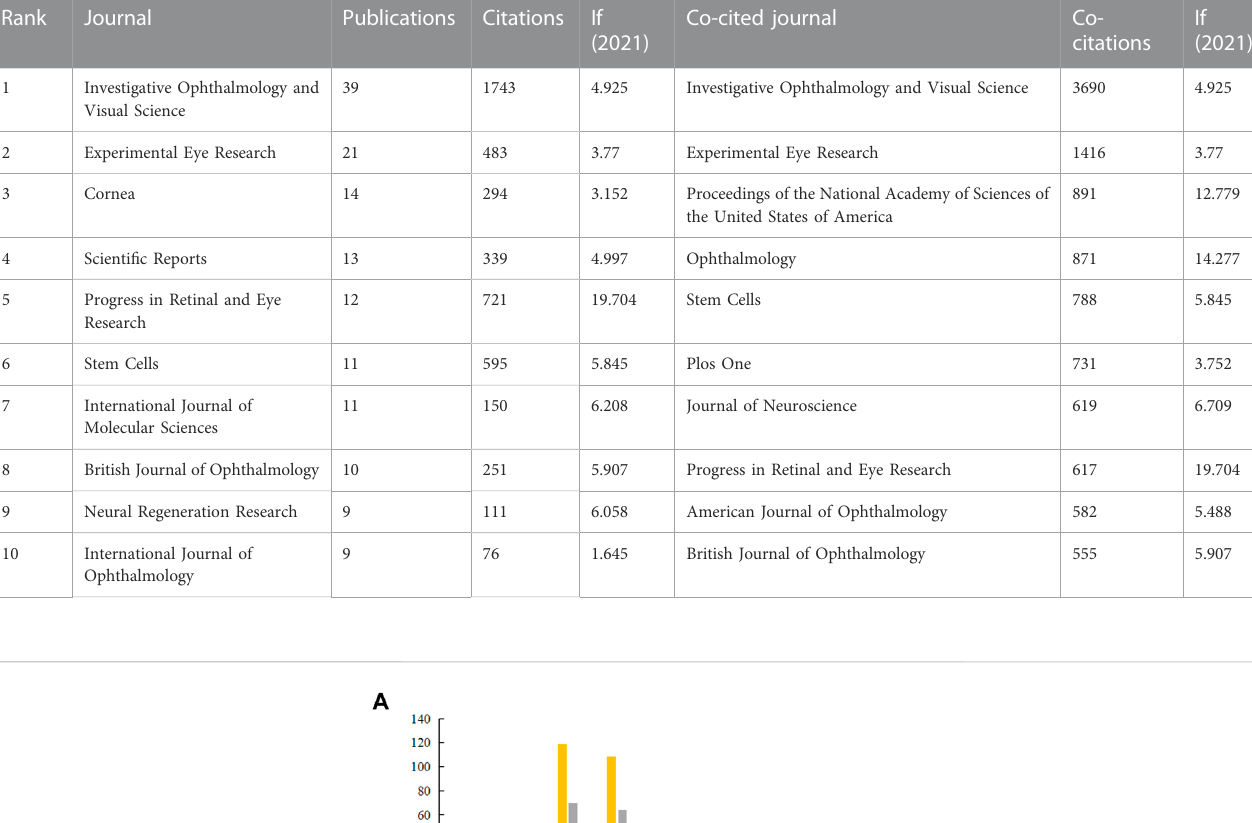
TABLE 2 Top 10 proli fi c journals and co-cited journals on the application of stem cells in glaucoma. Rank